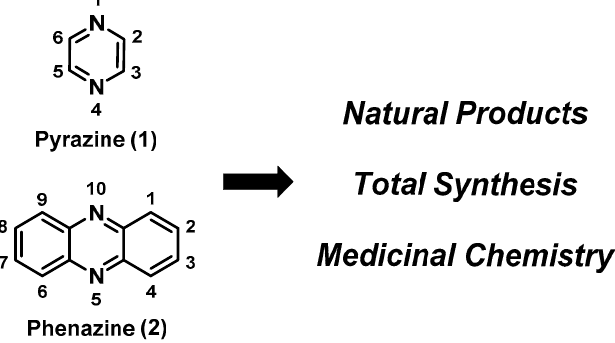
Figure 1. The chemical structures of pyrazine ( 1 ) and phenazine ( 2 ).